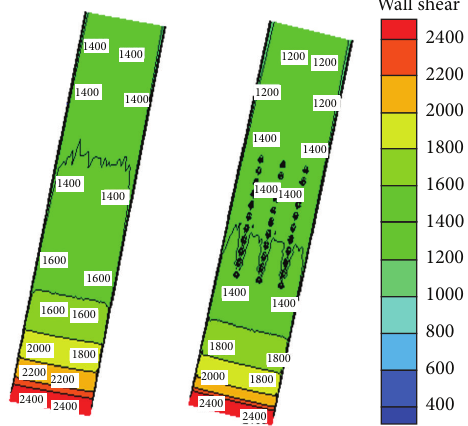
Figure 9: Comparison of wall shear stress.